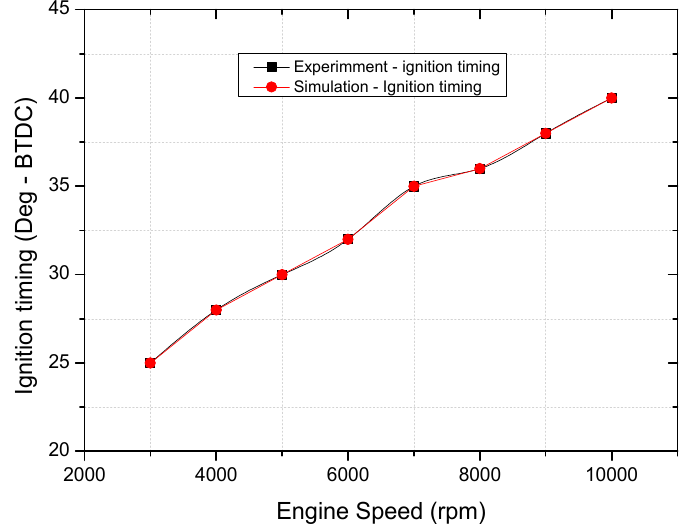
Figure 4. Ignition timing versus engine speed.